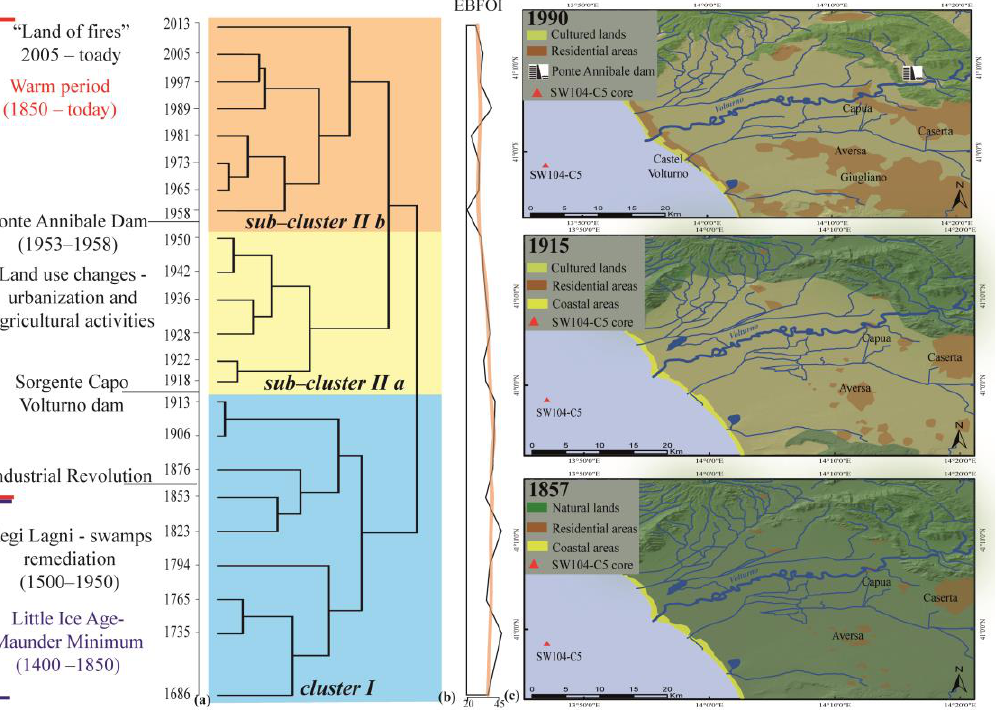
Figure 3. Paleoclimate periods (blue and red from Margaritelli et al. [22]) and anthropogenic in- terventions. ( a ) Hierarchical cluster analysis based on benthic foraminiferal relative abundances; ( b ) Enhanced benthic foraminifera oxygen index (EBFOI) temporal variations with a smooth curve (in orange) based on local polynomial regression fitting added to evidence the main trend; ( c ) Pale- oenvironmental reconstruction and land-use changes in 1857 [58], 1915 [59] and 1990